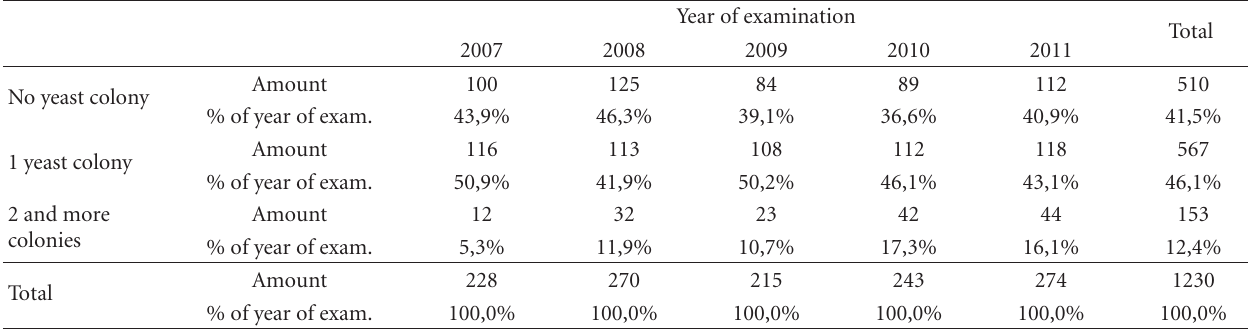
Table 12: Distribution of number of yeasts colony and no growth according to the year of